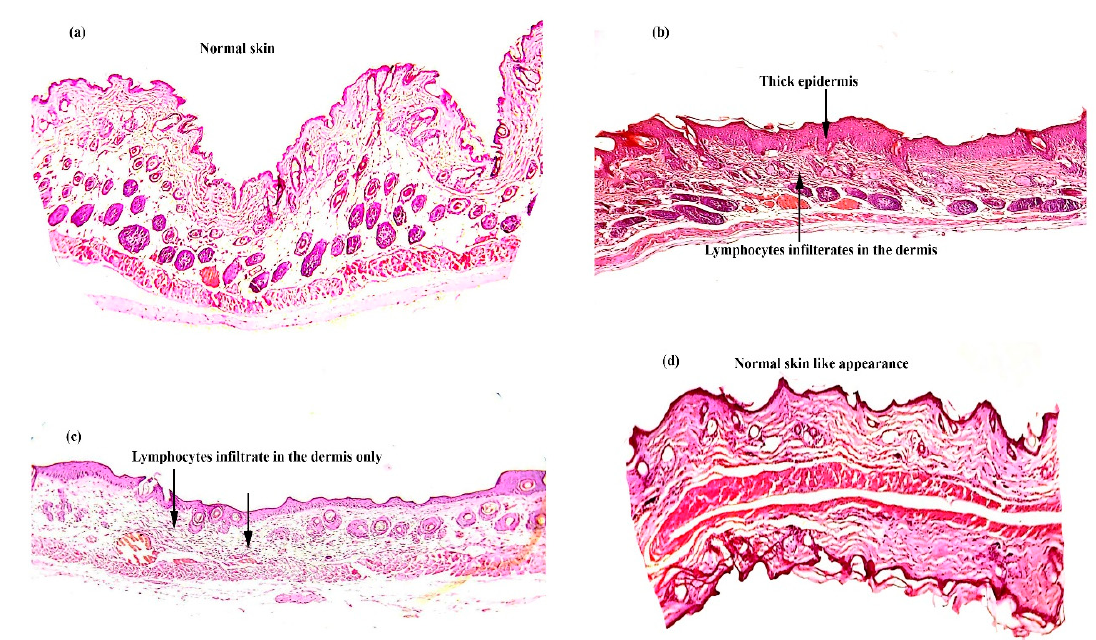
Figure 8. Histopathology of the skin of normal BALB/c mice after ten days of topical treatment: ( a ) untreated skin; ( b ) skin treated with the IMQ gel; ( c ) skin treated with IMQ-NEG; and ( d ) skin treated with IMQ-CUR-NEG (at 10x magnification).